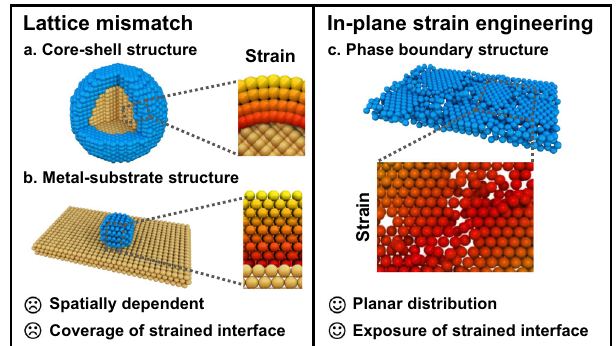
Fig. 1 Schematic illustration of strain engineering. a , b Strain engineering through the lattice mismatch approach in core-shell structure or metal- substrate structure, respectively. c The in-plane strain engineering through constructing amorphous – crystalline phase